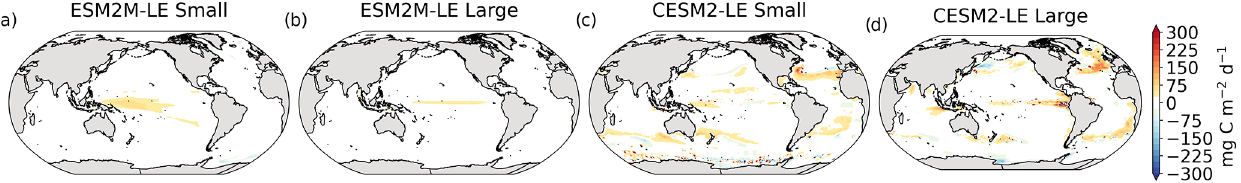
Figure B7. Difference between the NPP anomaly dNPP during compound MHW–NPPX events and its decomposition into a contribution of the growth rate anomaly n d µ and of the biomass anomaly µ d n (mgCm − 2 d − 1 ) during compound MHW–NPPX events for small and large phytoplankton in ESM2M-LE (a, b) and in CESM2-LE (c, d) .